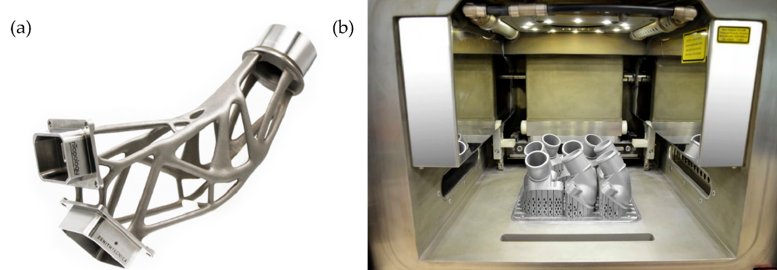
Figure 6. Example of metal aerospace designed liquid fuel injectors ( a ) by NASA, reproduced from [20,70] and ( b ) three-dimensional (3D) systems reproduced from [70] with permission from 3D systems.